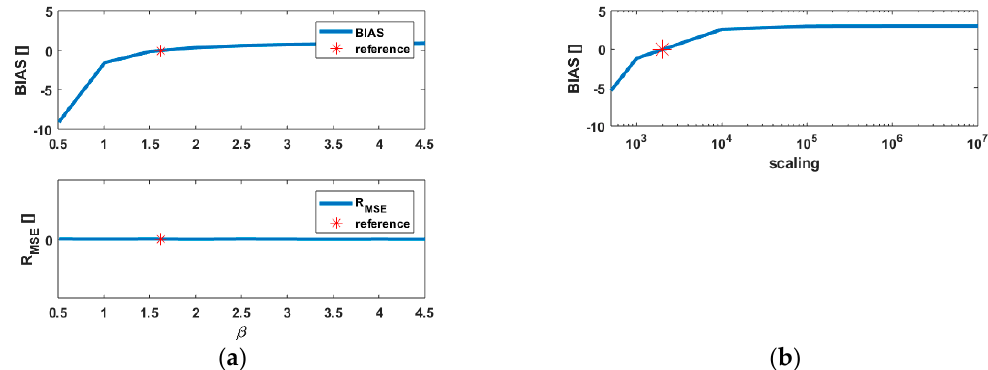
Figure 4. ( a ) Impact of variations of the scaling β of the intensity-based model for the bias of the loss of efficiency R MSE ( top ) and the a posteriori variance factor ( bottom ). All cases of interest lead to the same values; ( b ) BIAS for ˆ Q = γ I corresponding to a scaled identity matrix. Please note the log values of γ for the x-axis. The red star corresponds to BIAS = 0 and the intensity vector to case 1.